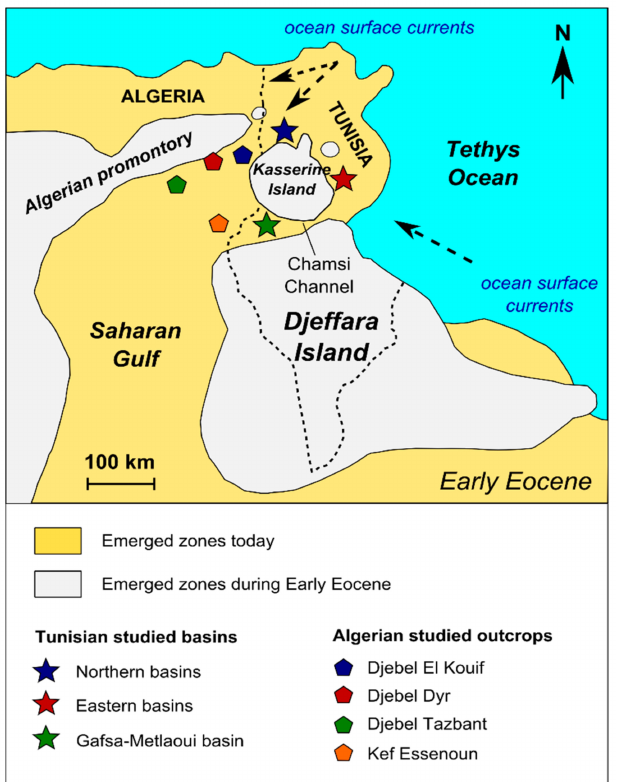
Figure 2. A (paleo)geographical sketch map of northern Africa continent showing also the present po- sition of the studied Tunisian and Algerian deposits in respect to the emerged zones during the Early Eocene. Dotted line is the actual border between Algeria and Tunisia. Modified after Zaïer et al. [33] and Garnit et al. [12].